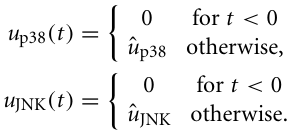
FIGURE 5 | Modulation of the bistable switch by negative feedback. (A) Scheme of the extended JNK model, in which active JNK induces the expression of DUSP1 mRNA ( mD ) and protein ( pD ). (B) Loop breaking analysis showing a transient bistable regime (light green). Blue: initial i/o characteristic of the open loop system at t = 30min, before the negative